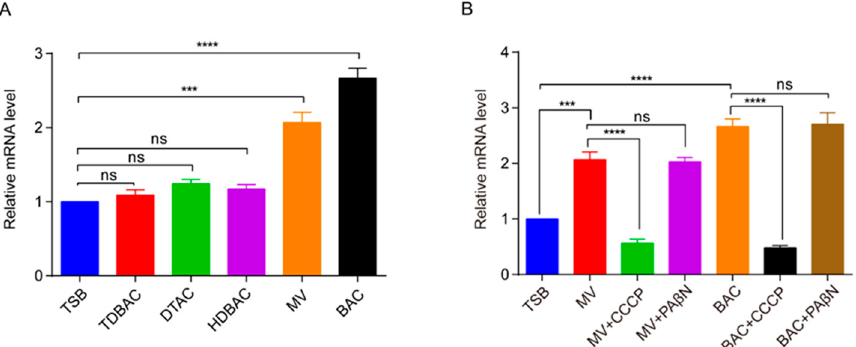
Figure 3. Relative fold changes of RanQ mRNA expression levels in R. anatipestifer RA-LZ01 after treatment with QACs and EPIs. The subinhibitory concentrations of QACs were added to the TSB broth (TDBAC, 2 µg/mL; DTAC, 2 µg/mL; HDBAC, 2 µg/mL; MV, 8 µg/mL; BAC, 2 µg/mL). TSB—tryptic soybean broth. ( A ) Quantification of the relative mRNA expression levels of the RanQ gene in the RA-LZ01 strain. ( B ) Relative fold changes of transcriptional level of the virulence experiment of R. anatipestifer WT RA-LZ01, deletion mutant Δ RanQ , and complemented strain c ∆ RanQ infecting ducklings. Gene induced by specific substrates in the parental strain. Transcriptional levels of the virulence experiment of R. anatipestifer WT RA-LZ01, ∆ RanQ , and c ∆ RanQ infecting ducklings. (ns p ＞ 0.05, *** p < 0.001, **** p < 0.0001).